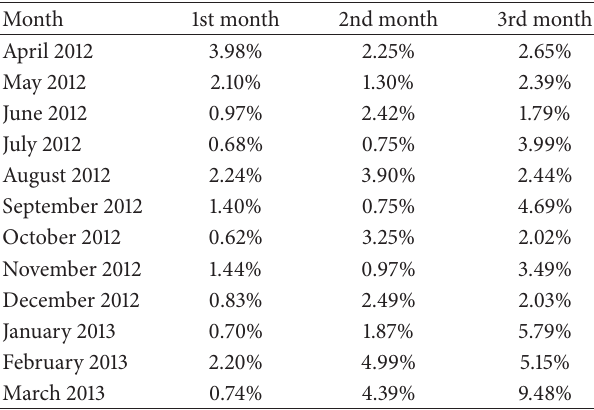
Table7:Inthefirstcolumn,wehavethemonthsofelectricitysupply of the peak contracts considered, while in the next three columns we have the mean absolute percentage errors obtained in the long-term forecasts of the contracts value during the first, second, and third month of trading, respectively, using a geometric Brownian